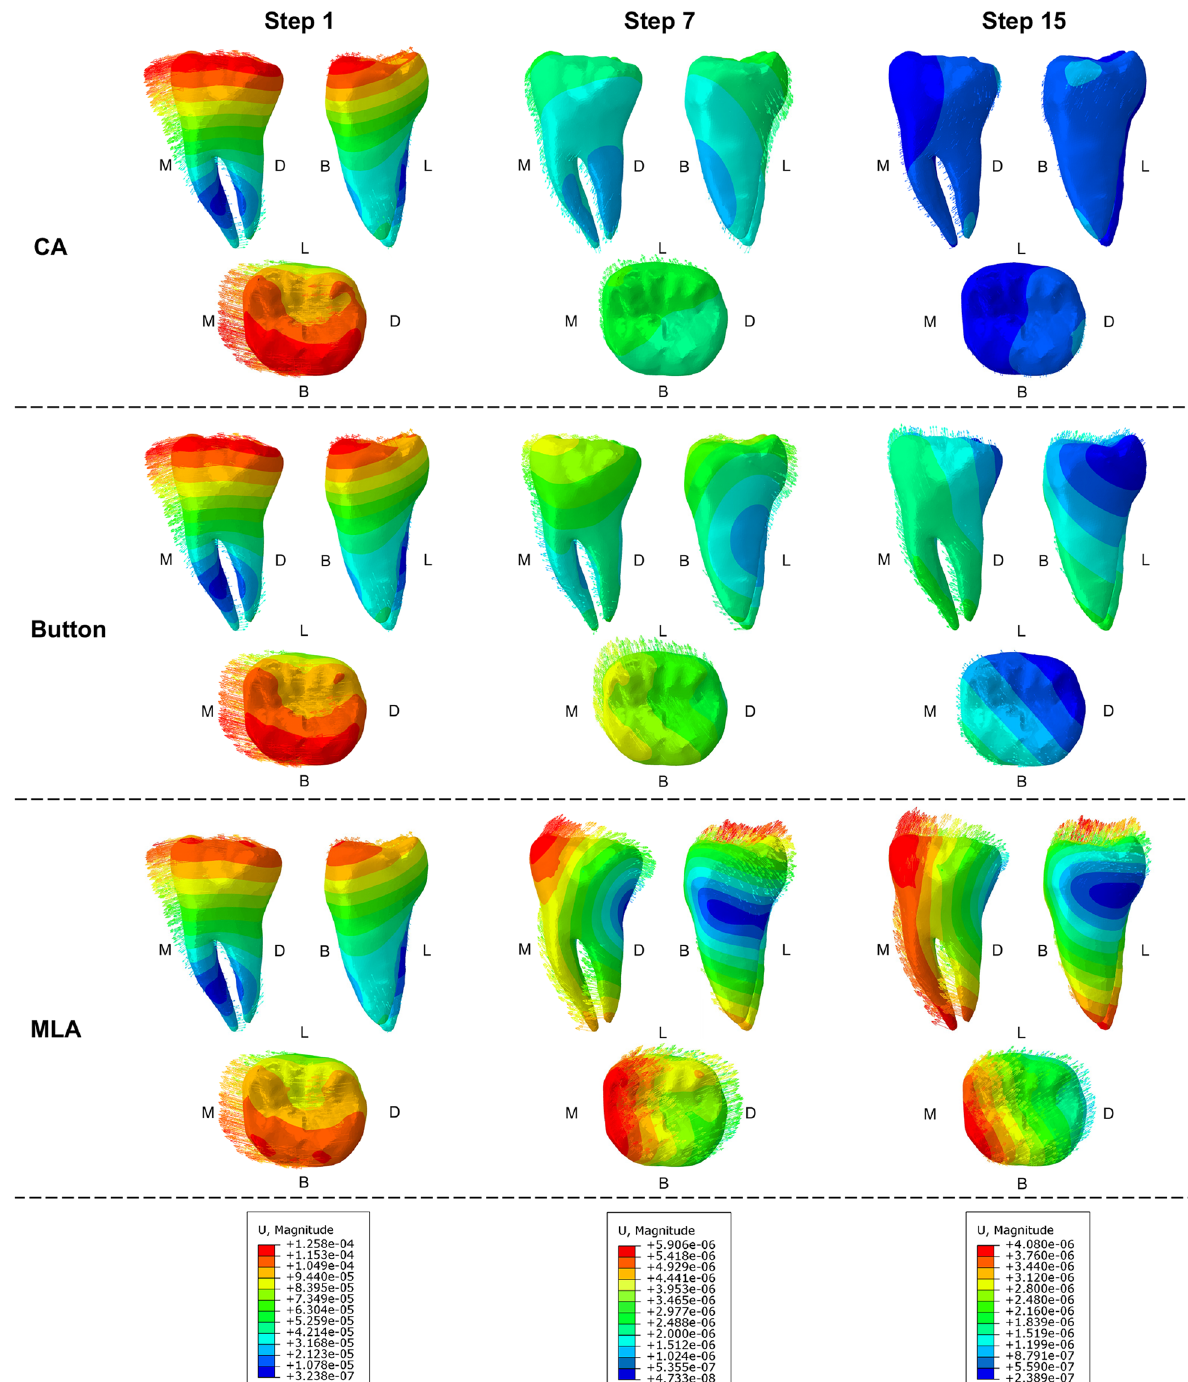
Fig. 7 Displacement tendency of M2 at the beginning, intermediate, and final steps. *M, D, B, and L stand for mesial, distal, buccal, and lingual,